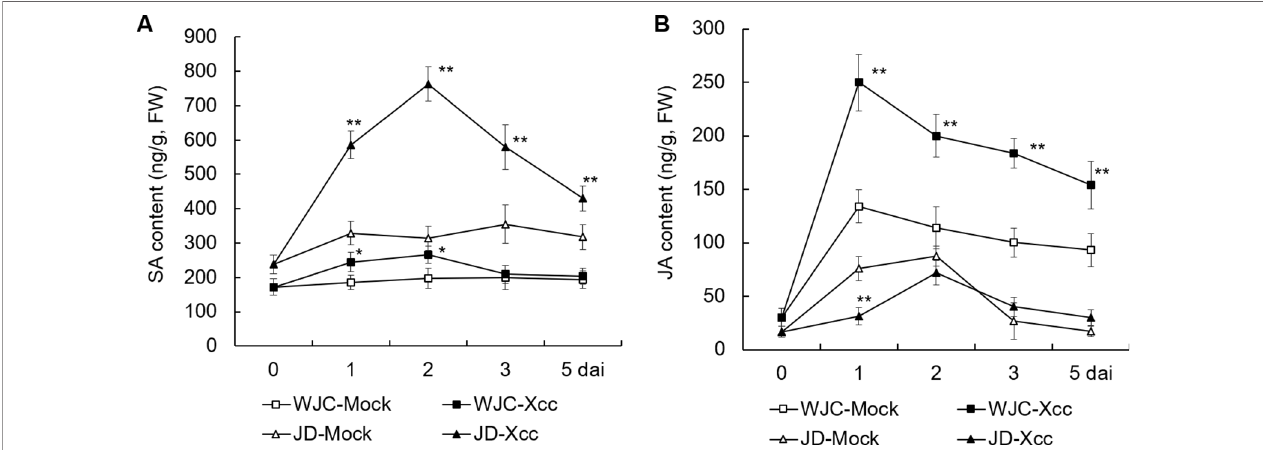
FIGURE 2 | Dynamic changes in endogenous SA and JA contents of Xcc-resistant and -susceptible orange cultivars. (A) SA content of Wanjincheng orange and Jindan leaves. (B) JA content of Wanjincheng orange and Jindan leaves. Fully expanded citrus leaves were injected with 5 × 10 5 cfu/mL Xcc suspensions, and samples receiving a water treatment were used as blank controls. SA and JA contents were determined by HPLC before and after inoculation. Error bars indicate the SDs of three biological repeats. Statistical signi fi cance related to their own mock control was determined by two-tailed Student ’ s t -test (*, P < 0.05; **, P < 0.01).